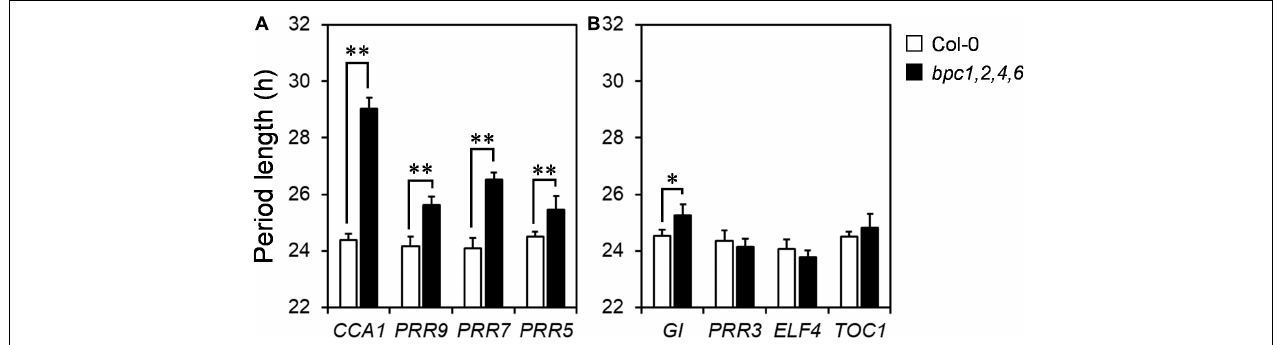
FIGURE 5 | Clock genes are phase delayed in bpc1-1 bpc2 bpc4 bpc6. Period lengths of genes phased before (A) and after evening (B) under constant light were calculated by using MFourFit deposited at BioDare2 (Zielinski et al., 2014; https://biodare2.ed.ac.uk/). Data are mean ± S.E. ( n = 6, the data include three technical repeats of two independent biological replicates). Asterisks indicate period length was significantly delayed in bpc1,2,4,6 mutant (Student’s t- test; ∗∗ P < 0.01, ∗ P < 0.05).